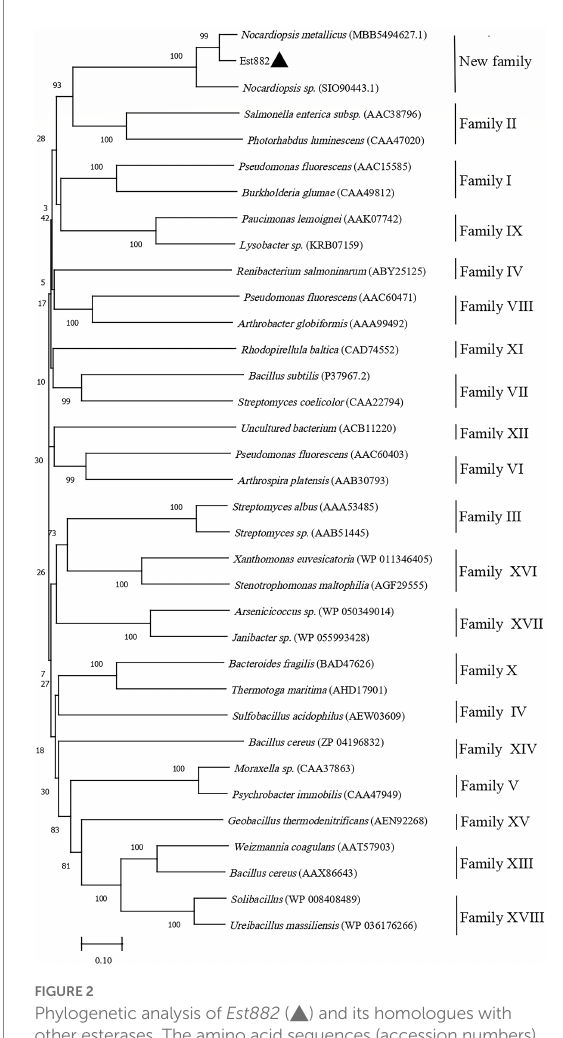
FIGURE 2 Phylogenetic analysis of Est882 ( ▲ ) and its homologues with other esterases. The amino acid sequences (accession numbers) of all enzymes were retrieved from GenBank.